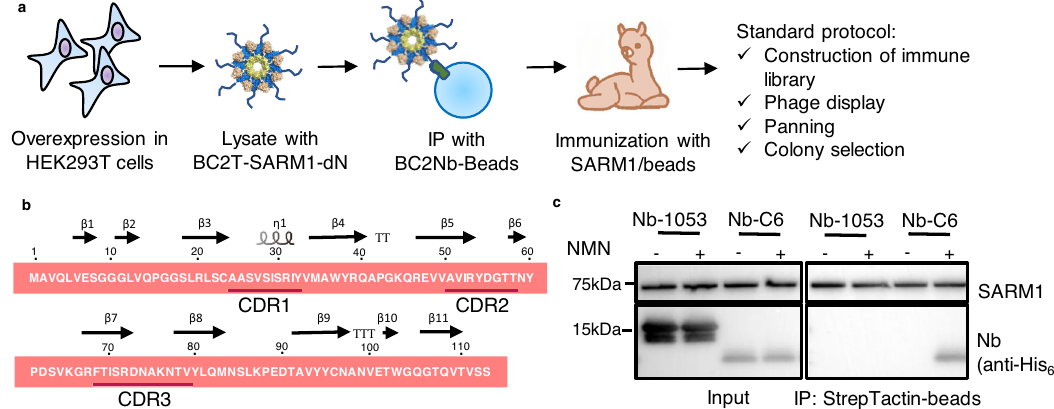
Fig.1|NanobodyC6bindstotheNMN-activatedSARM1.a TheprocessofNb-C6 development. b The primary sequenceand secondarystructureofNb-C6. c